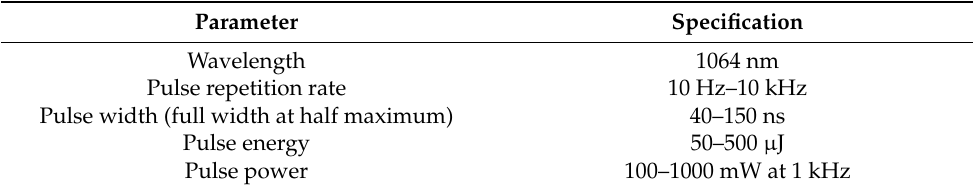
Table 1. Specifications of the developed doubly Q-switched 1064 nm Nd:YAG laser.